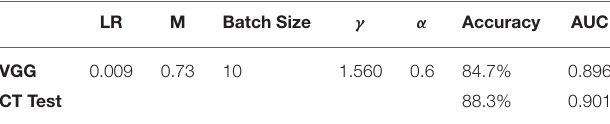
TABLE 3 | Results of optimizing network and network hyperparameters using the particle swarm algorithm (discussed in the